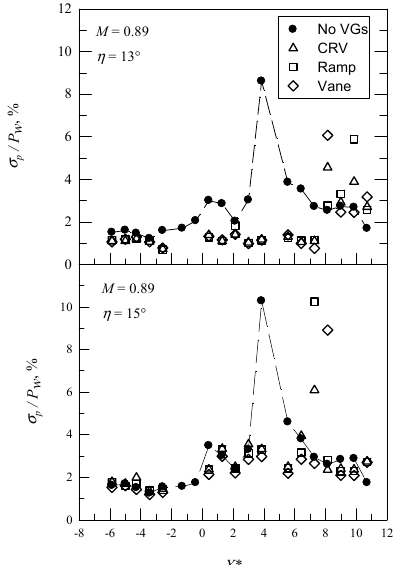
Figure 12. Surface pressure fluctuations for M = 0.89. The variation in ( σ p / P w ) max with/without MVGs is shown in Figure 13. For the baseline case, ( σ p / P w ) max is mainly associated with SIBLS and shock oscillation. The value of ( σ p / P w ) max decreases if MVGs are used. For CRV MVGs, the primary flow passes through the split of the counter vanes and interacts with the flow that develops from each half of the device. The counter-rotating vortices are larger and stronger or flow